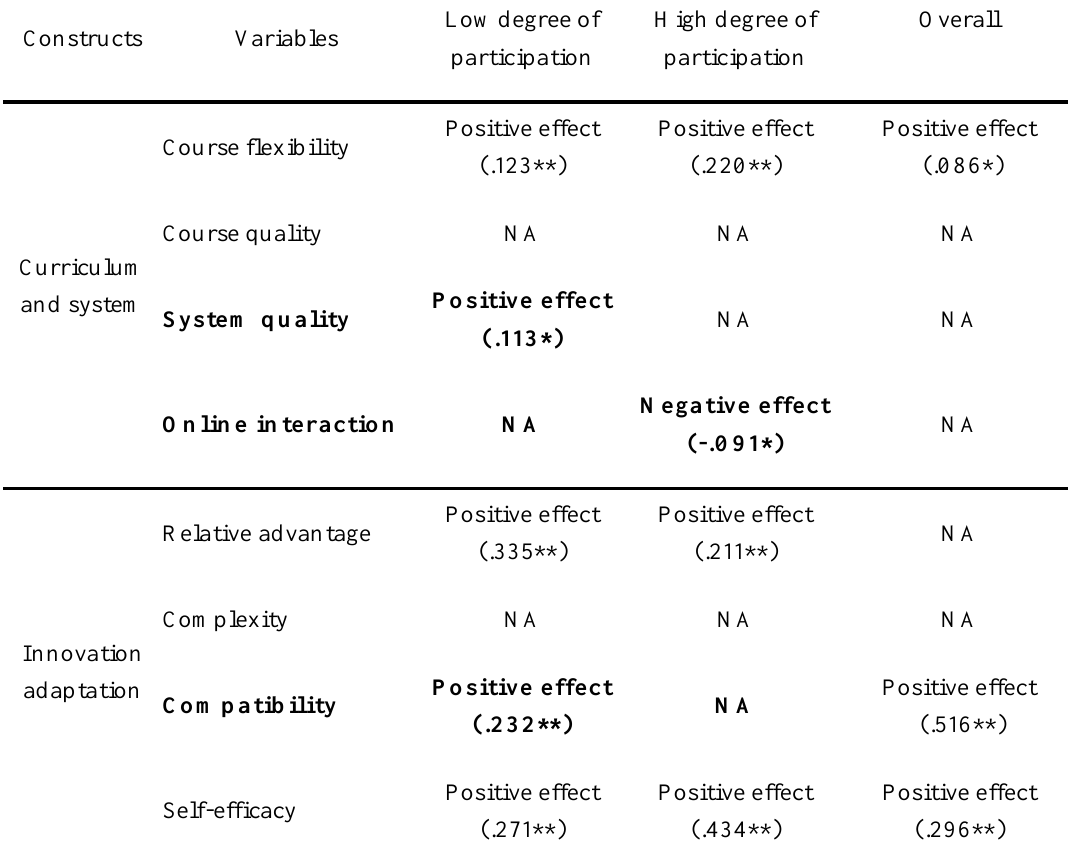
Factors Affecting E-Learning Continued